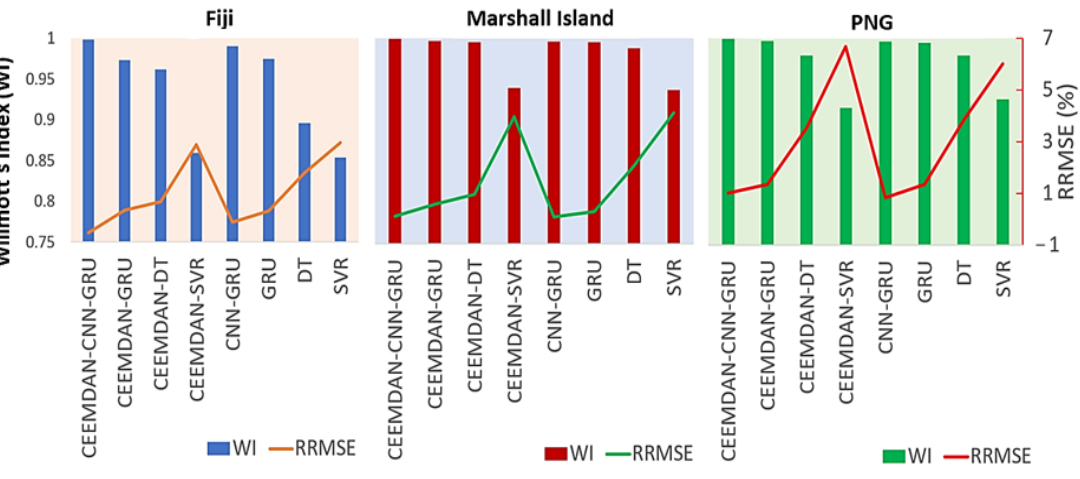
Figure 9. Comparison of the forecasting ability of proposed models in terms of RRMSE (%) and WI in the testing phase.